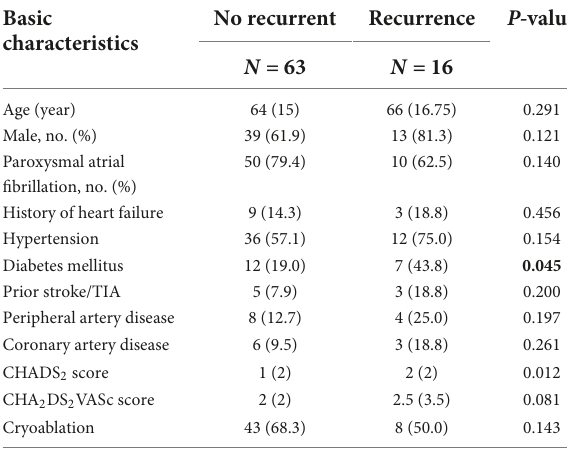
TABLE 1 Baseline characteristics of the study participants.